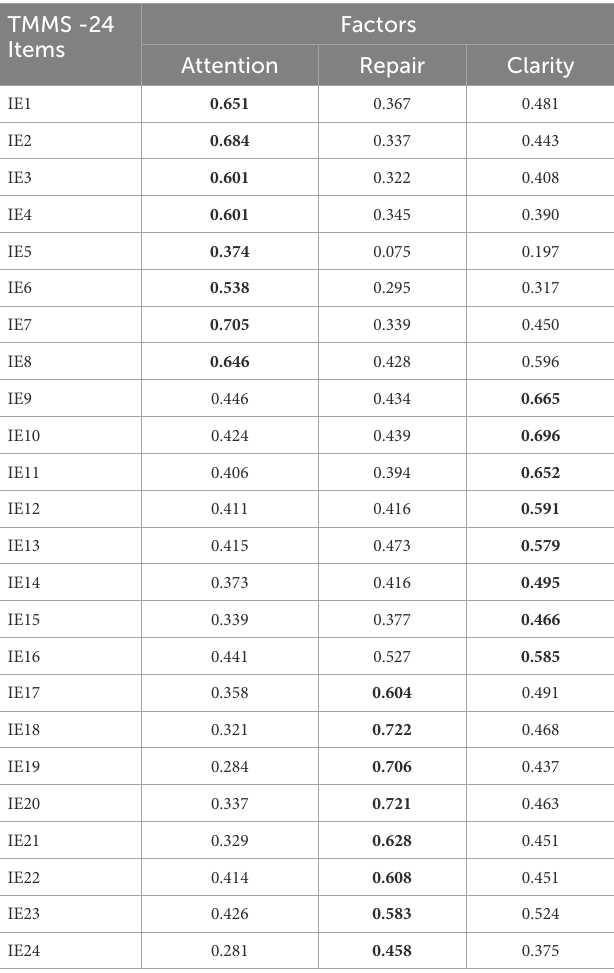
TABLE 1 Structure matrix of the TMMS-24 in the exploratory factor analysis. TMMS -24 Items